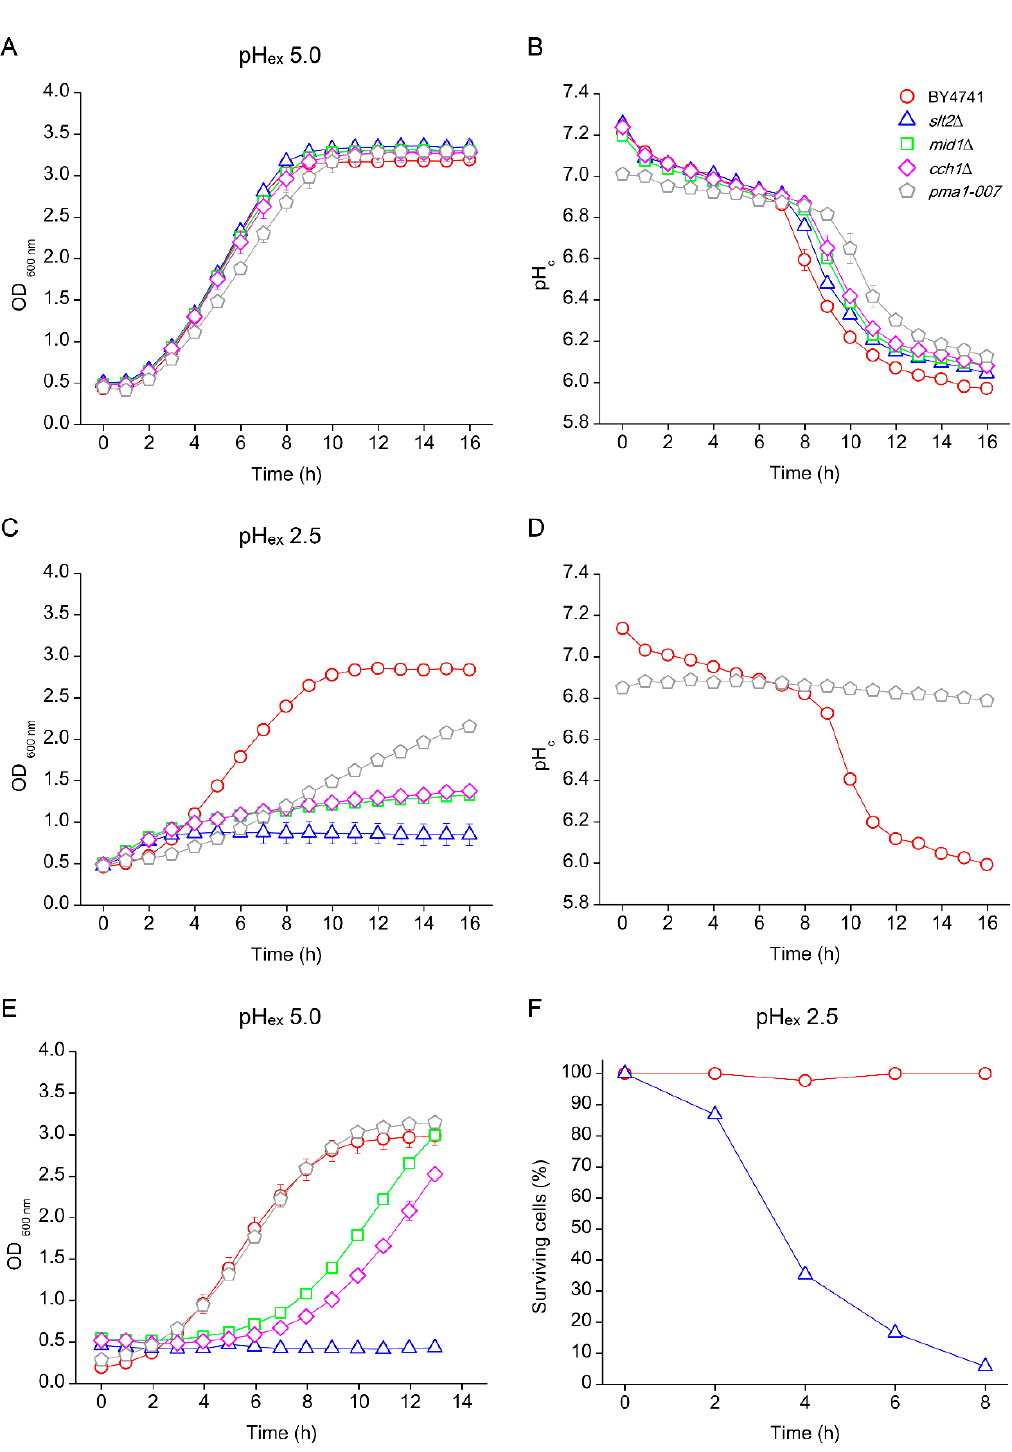
Figure 5. E ff ect of low external pH (pH ex ) on growth profile ( A , C ) and cytosolic pH (pH c ) ( B , D ) of S. cerevisiae. Cells of BY4741 wild type strain (red circles) and its isogenic mutants slt2 ∆ (blue triangles), mid1 ∆ (green squares), cch1 ∆ (pink diamonds) and pma1-007 (grey pentagon) were cultivated in YNB adjusted to pH 5.0 ( A , B ) or pH 2.5 with sulphuric acid ( C , D ). Samples were collected from the end of cultivation in YNB pH 2.5 ( C ) and reinoculated to YNB pH 5.0 ( E ) or at di ff erent times of cultivation in YNB pH 2.5 and quantified for the percentage of viable cells ( F ).